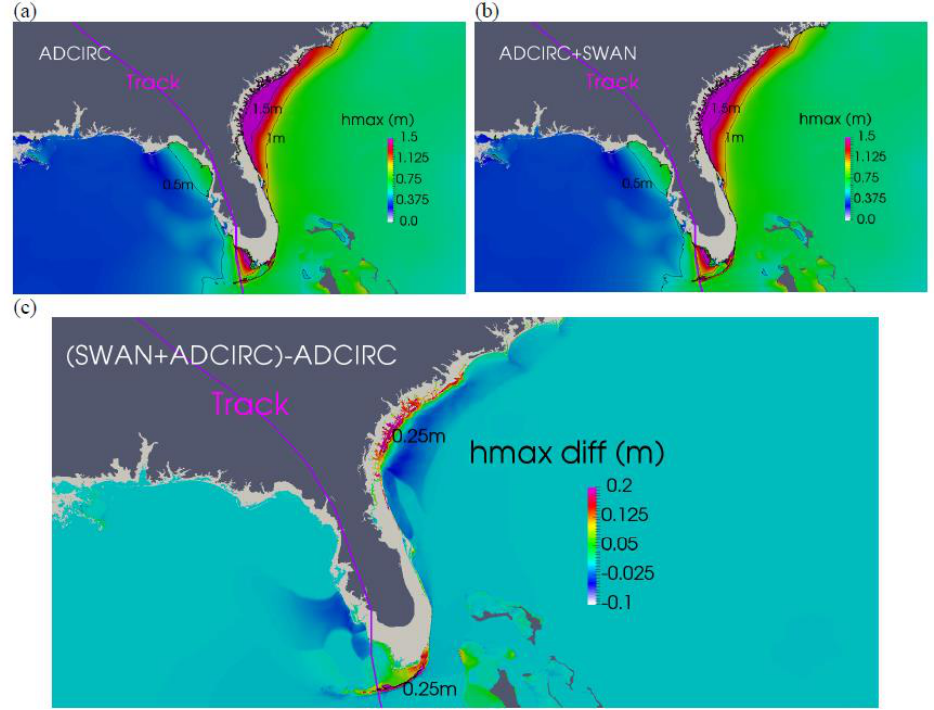
Figure 2. Contour plots of Hurricane Irma’s maximum water surface elevation in meters. ( a ) ADCIRC; ( b ) ADCIRC+SWAN; ( c ) (ADCIRC+SWAN)-ADCIRC.